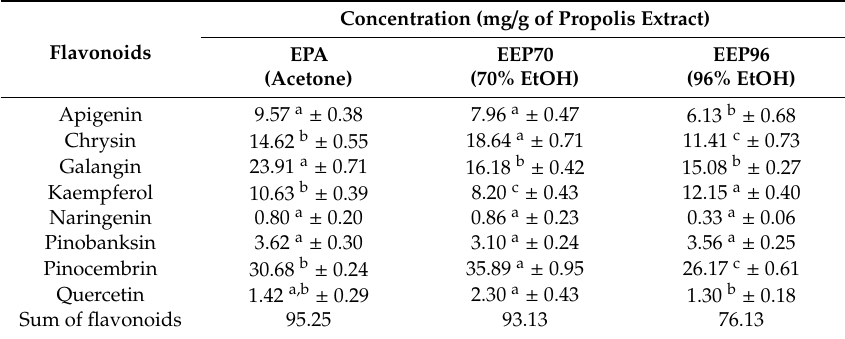
Table 1. Flavonoid concentrations in propolis extracts.